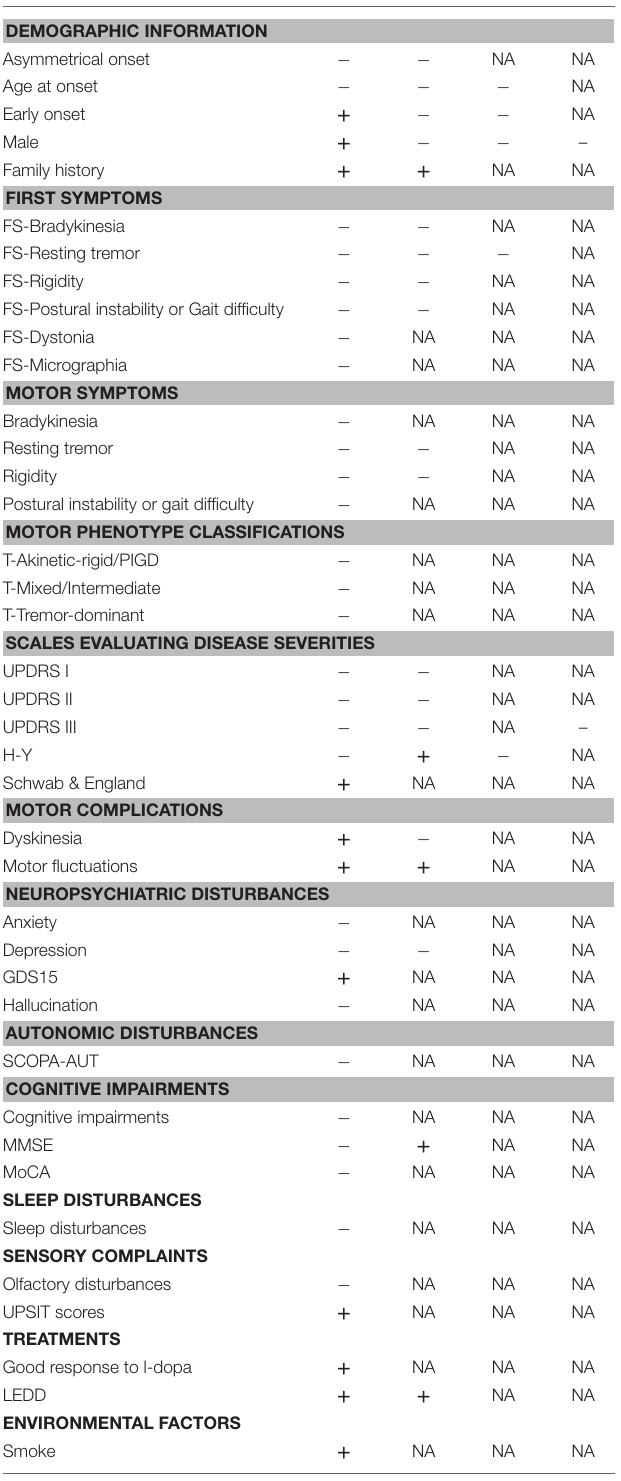
TABLE 2 | The results of phenotype-association analysis of each variant of LRRK2